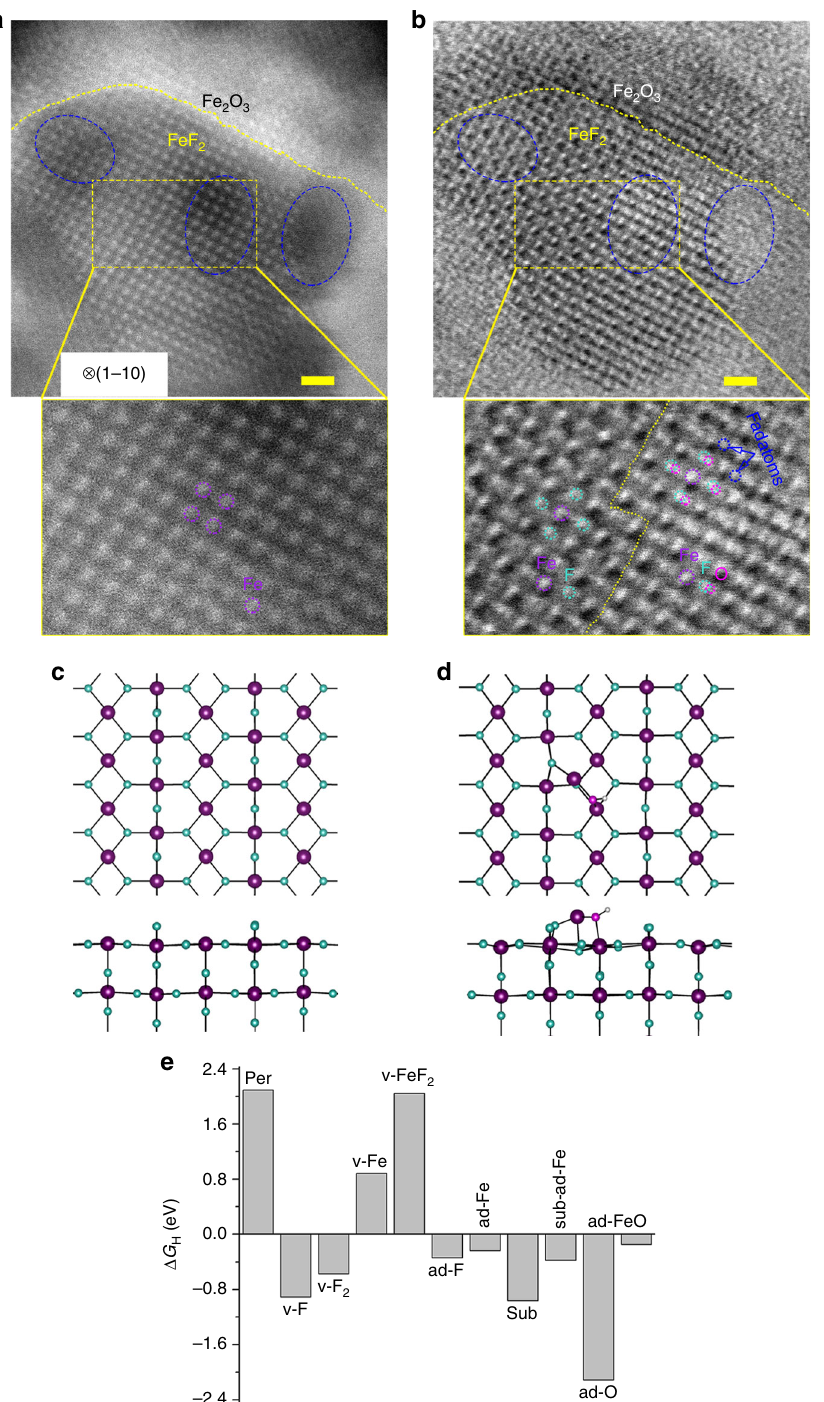
Fig. 5 Typical atomic-level STEM images and DFT calculations of defect-riched IFONFs-45. a HAADF-STEM image of IFONFs-45 taken from [1 – 10] direction of FeF 2 . The enlarged views of exact objects in the dashed-box depict detailed distribution of Fe atoms. b BF-STEM image of IFONFs-45. The FeF 2 tetragonal lattice consisting of Fe (purple dots) and alternating F (turquoise dots) atoms is readily distinguished in left side of dashed-box. The neighboring columns depict faint O signals (magenta dots) at the right of interface, as Fe and F atoms are brighter than the substituted O atoms in bright- fi eld mode. Atomic structure of FeF 2 (110) surface, with stoichiometric termination ( c) , and adsorbed with O, Fe, and H ( d ). Fe: purple; F: turquoise; O: magenta; H: white. Both top and side views are revealed. e Free energy of H adsorption on different sites. “ per ” means perfect (stoichiometric) surface, “ v ” represents vacancies, “ ad ” for adatoms, “ sub ” for F substituted by O, and “ sub-ad-Fe ” for Fe adatom on O that substituted F. Scale bar, 1